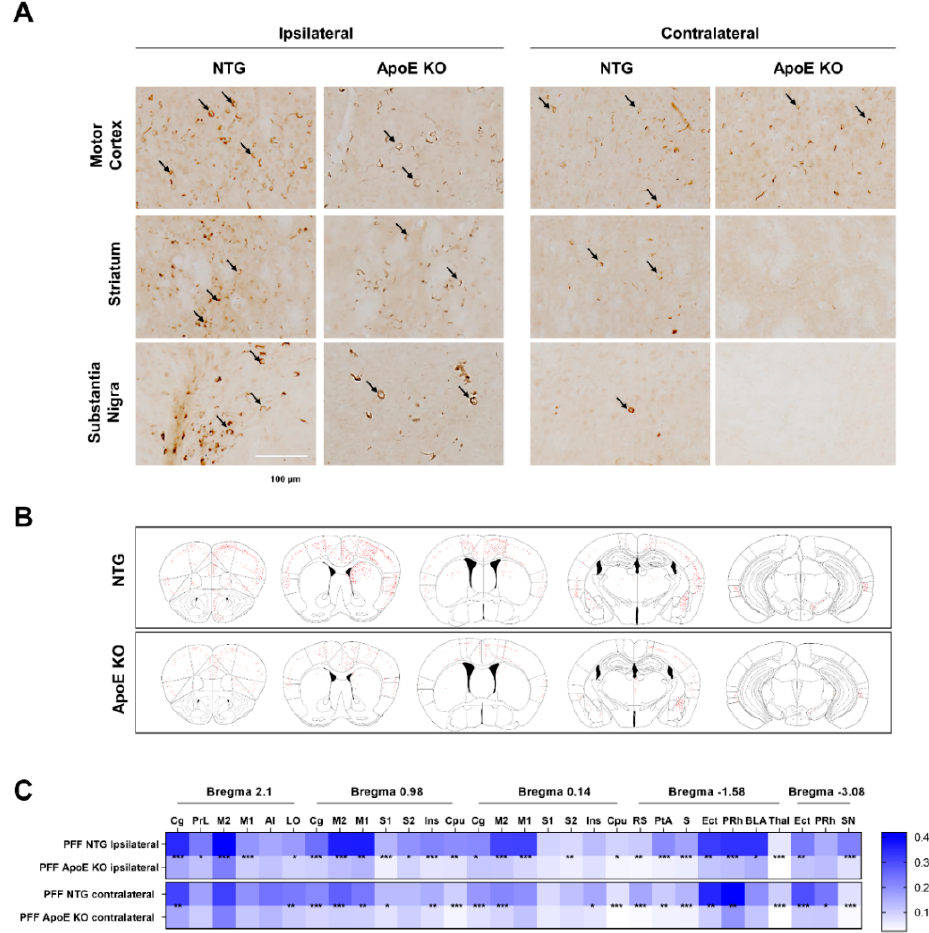
Figure 7. The propagation of α -syn is reduced in ApoE KO mice. ( A ) The 2–3-month-old WT ( n = 13) and ApoE KO ( n = 9) mice were injected into the striatum with 10 µ g of recombinant mouse α -syn fibrils. After 12 weeks, immunohistochemistry of pSer129 α -syn was performed. Arrow indicates pSer129 α -syn-positive inclusions. Scale bar indicates 100 µ m. ( B ) Schematic representation of α -syn inclusion pathology detected by pSer129 α -syn staining. ( C ) Heatmap shows the percentage of thresholds area detected with pSer129 α -syn pathology. * p < 0.05, ** p < 0.01, *** p < 0.001 against the control by unpaired t